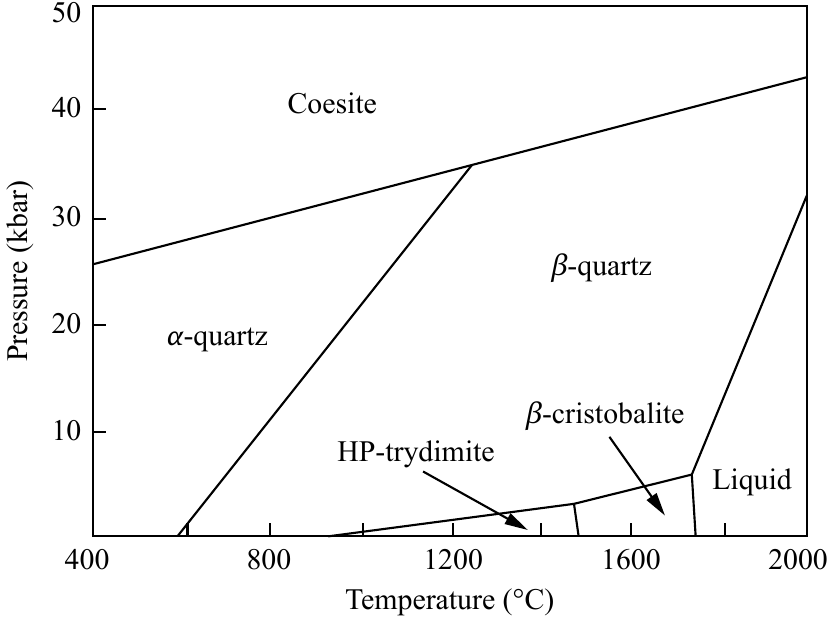
Figure 1. Phase diagram of SiO 2 showing its main crystalline forms as well as the liquid (melted)